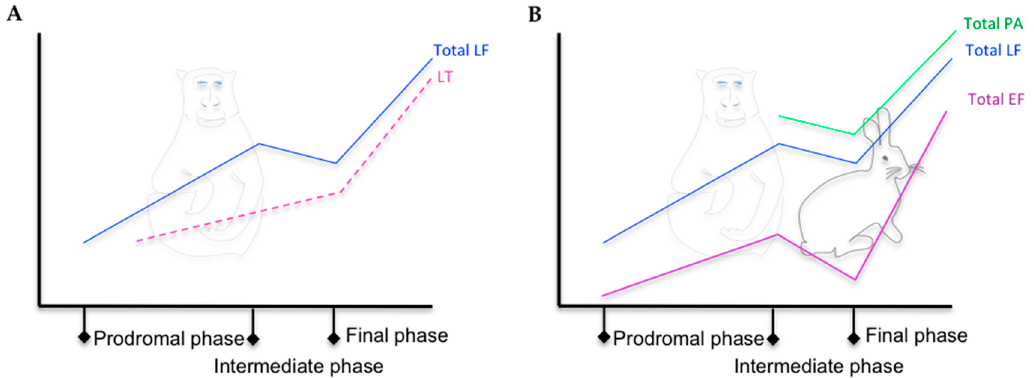
Figure 3. ( A ) Kinetic trends of total LF and LT level in the serum of RMs with inhalation anthrax, adapted from [45]. ( B ) Kinetic trends of total LF, EF, and PA level in the serum of RMs and New Zealand white rabbits with inhalation anthrax, adapted from [39,45,50,51,58].